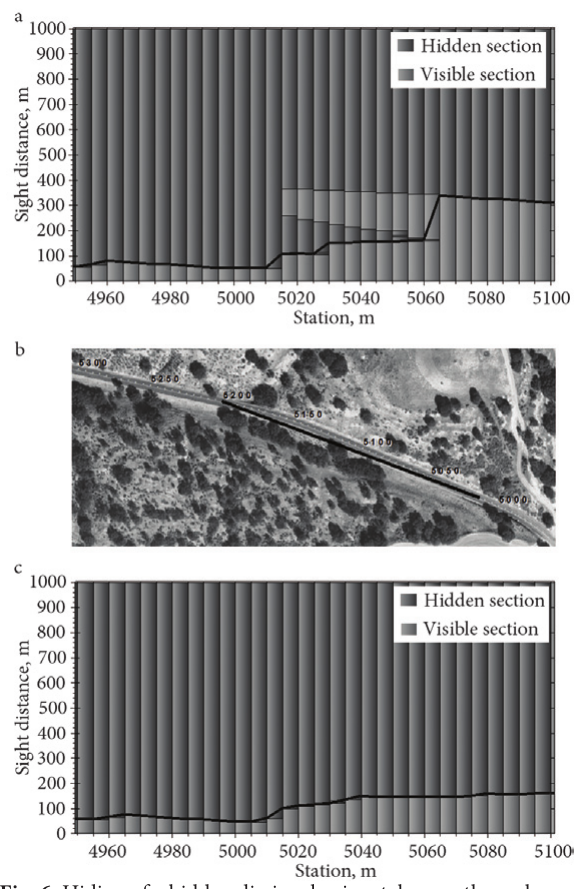
Fig. 6. Hiding of a hidden dip in a horizontal curve through